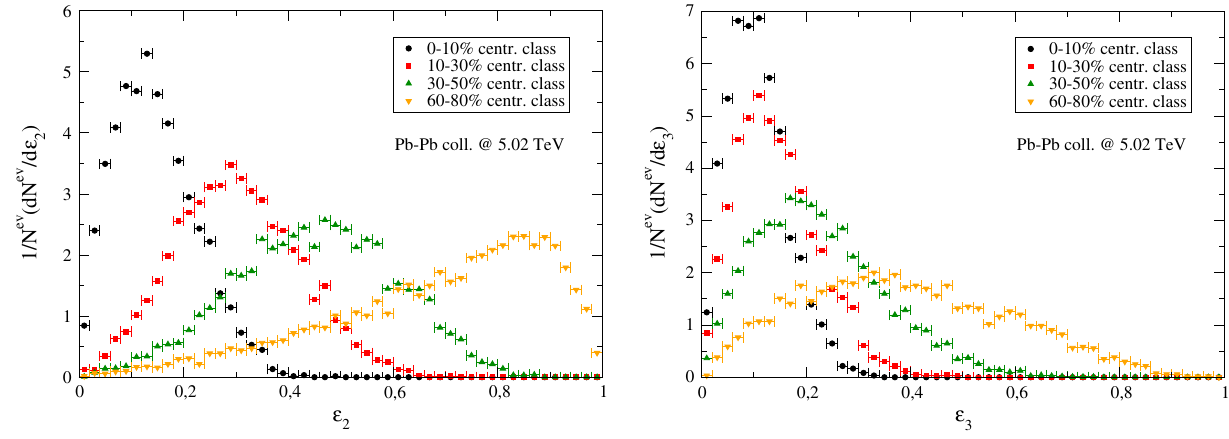
√ s NN = 5 . 02 TeV belonging to different